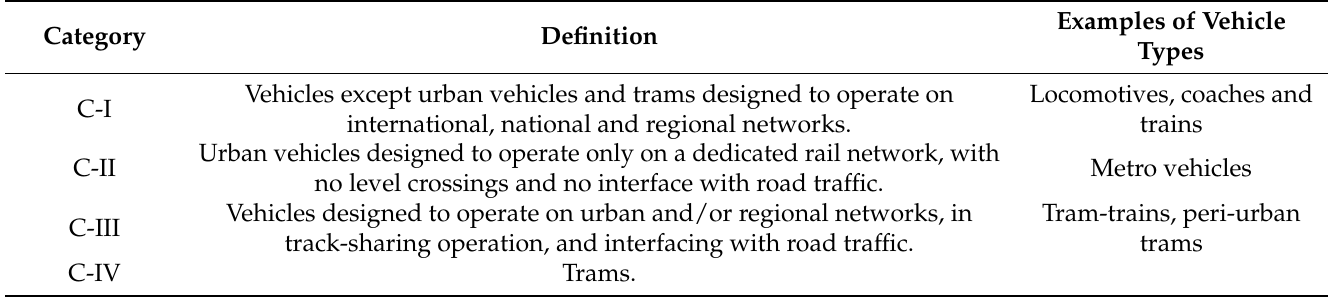
Table 7. Crashworthiness design categories of rail vehicles.